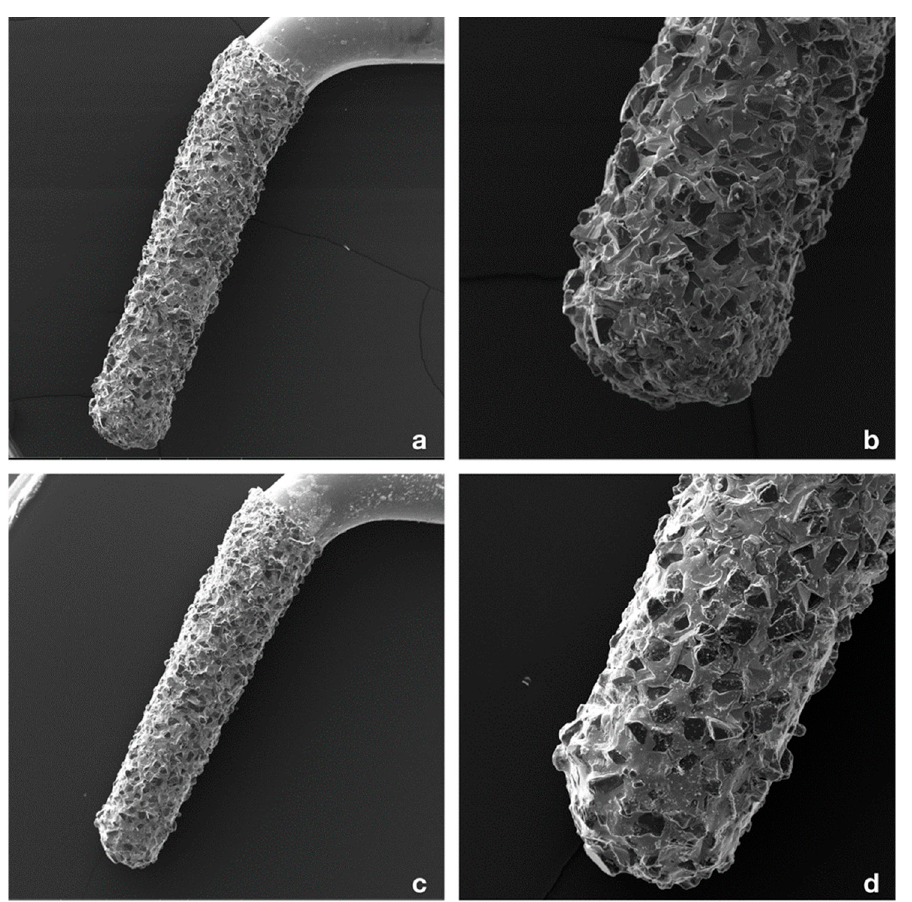
Figure 3. ( a ) SEM magnification of tip R1D (Piezomed, W&H, Bürmoos, Austria); ( b ) Details of the tip; note the regular position of the diamonds; ( c ) SEM magnification of tip R1D (Piezomed, W&H, Bürmoos, Austria) after utilization (20 min and 2 sec); ( d ) Details of the tip; note the reduction of the number of diamonds compared to ( a ).